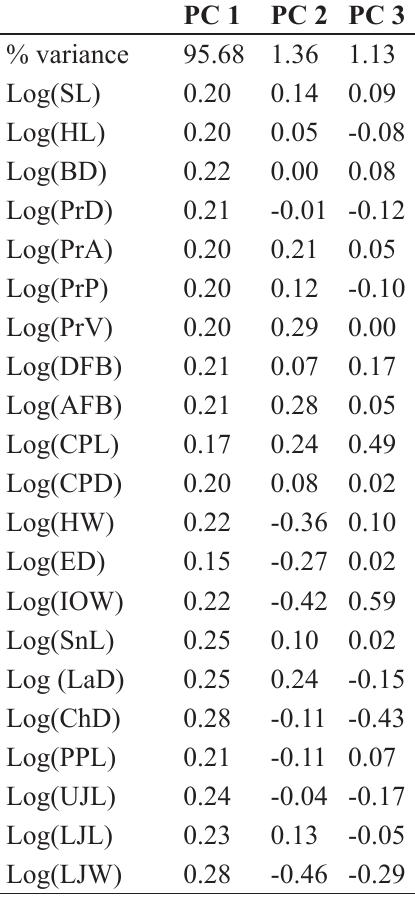
Table S2. PCA loadings of 21 log-transformed measurements from: H . mentatus , H . kimondo sp. nov., H . rex sp. nov., H . simba sp. nov., and H . glaucus sp. nov. Results illustrated in Fig. 3b. Abbreviations: SL = standard length; HL = head length; BD = body depth; PrD = predorsal distance; PrA = preanal distance; PrP = prepectoral distance; PrV = prepelvic distance; DFB = dorsal fin base length; AFB = anal fin base length; CPL = caudal peduncle length; CPD = caudal peduncle depth; HW = head width; ED = eye diameter; IOW = interorbital width; SnL = snout length; LaD = lachrymal depth; ChD = cheek depth; PPL = premaxillary pedicel length; UJL = upper jaw length; LJL = lower jaw length; LJW = lower jaw